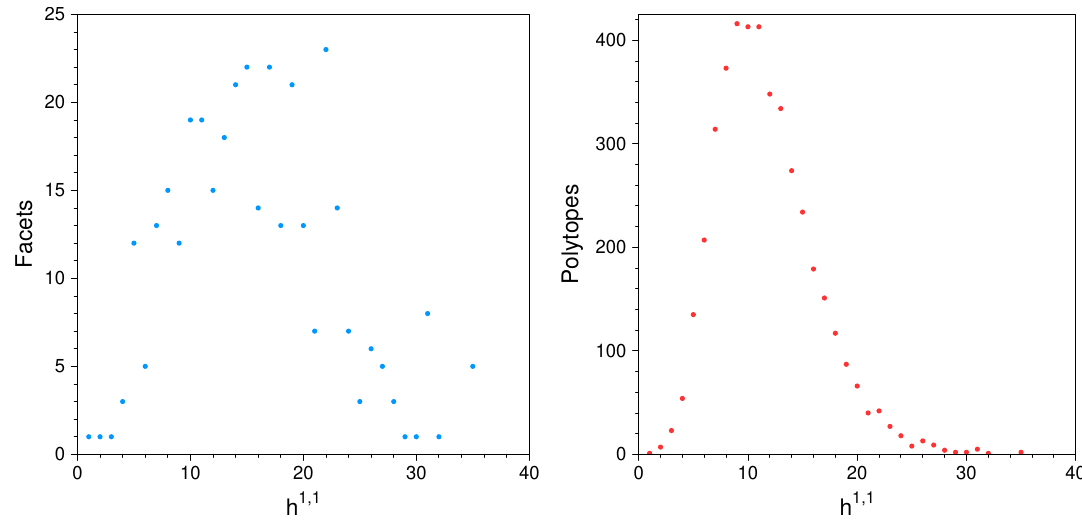
Figure 10 . (Left) The number of new facets at each h 1 ; 1 value. (Right) The number of re(cid:13)exive polytopes at each h 1 ; 1